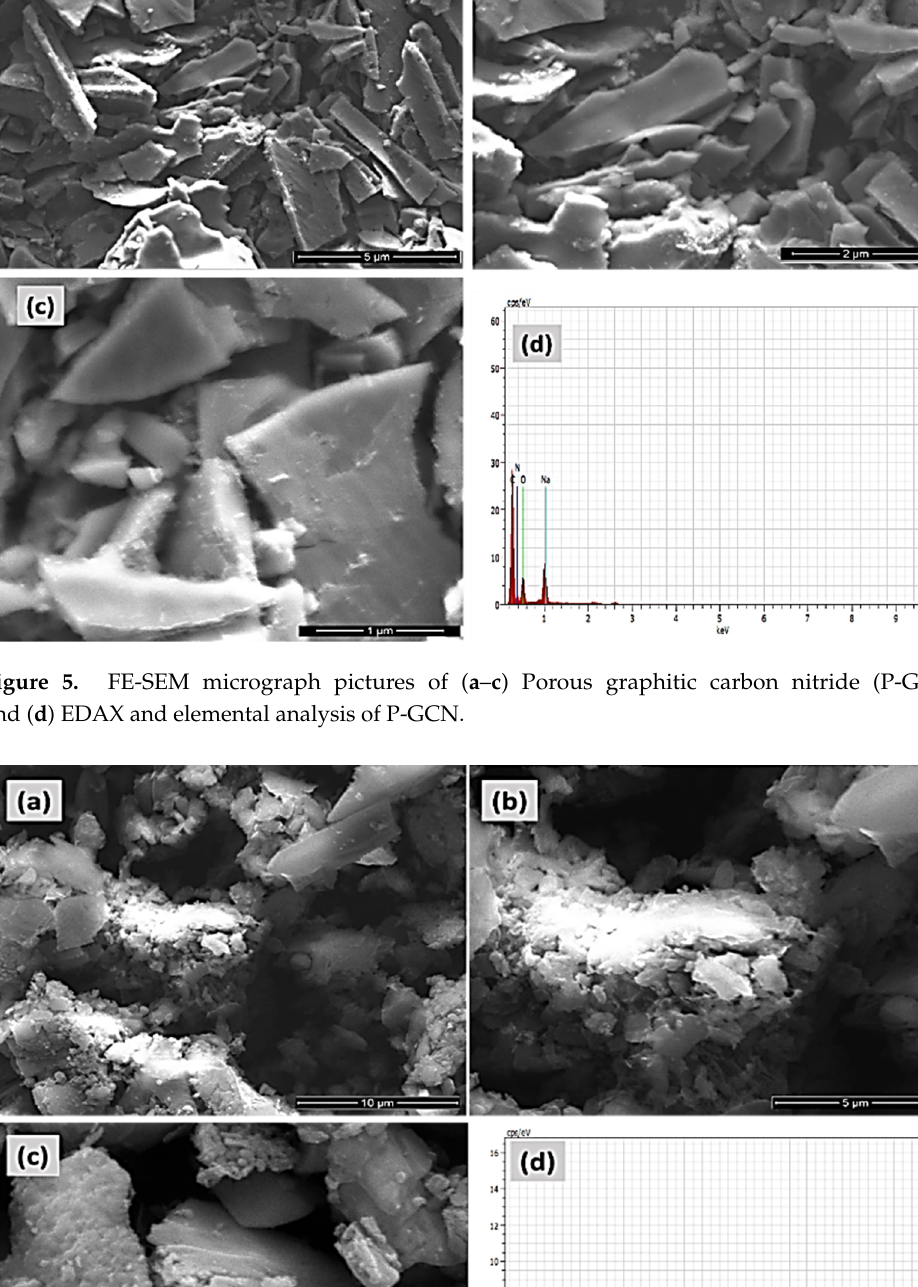
Figure 7. FE-SEM micrograph pictures of ( a – c ) covalent organic polymer (COP-N), and ( d ) EDAX elemental analysis of COP-N.